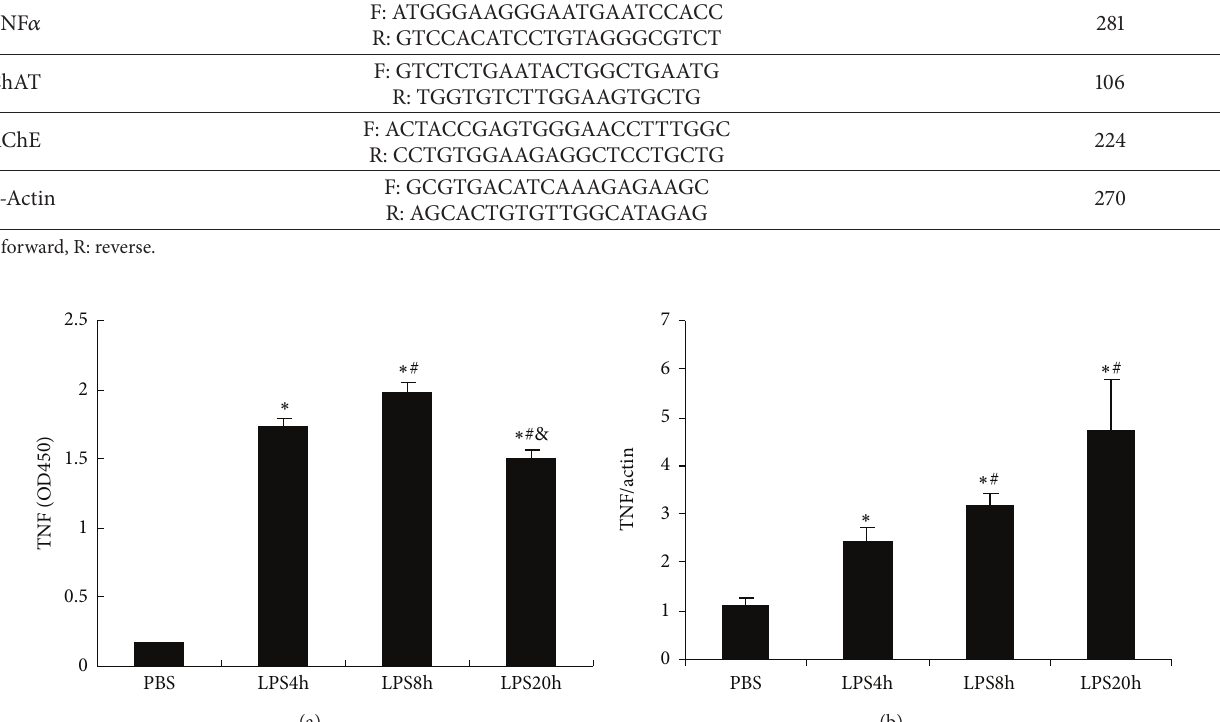
Figure 1: Kinetics of TNF protein and mRNA expression in RAW264.7 cells stimulated with 100 ng/mL LPS. (a) TNF content in the supernatant was determined by ELISA; data are shown as OD450; (b) TNF mRNA expression level was determined by using real-time PCR. 𝛽 -Actin was used as a control gene. The data shown are representative of three independent experiments. All values are expressed as mean ± SD ( 𝑛 = 3 ). ∗ 𝑃 < 0.05 compared with PBS, # 𝑃 < 0.05 compared with LPS 4h, and & 𝑃 < 0.05 compared with LPS 8 h.